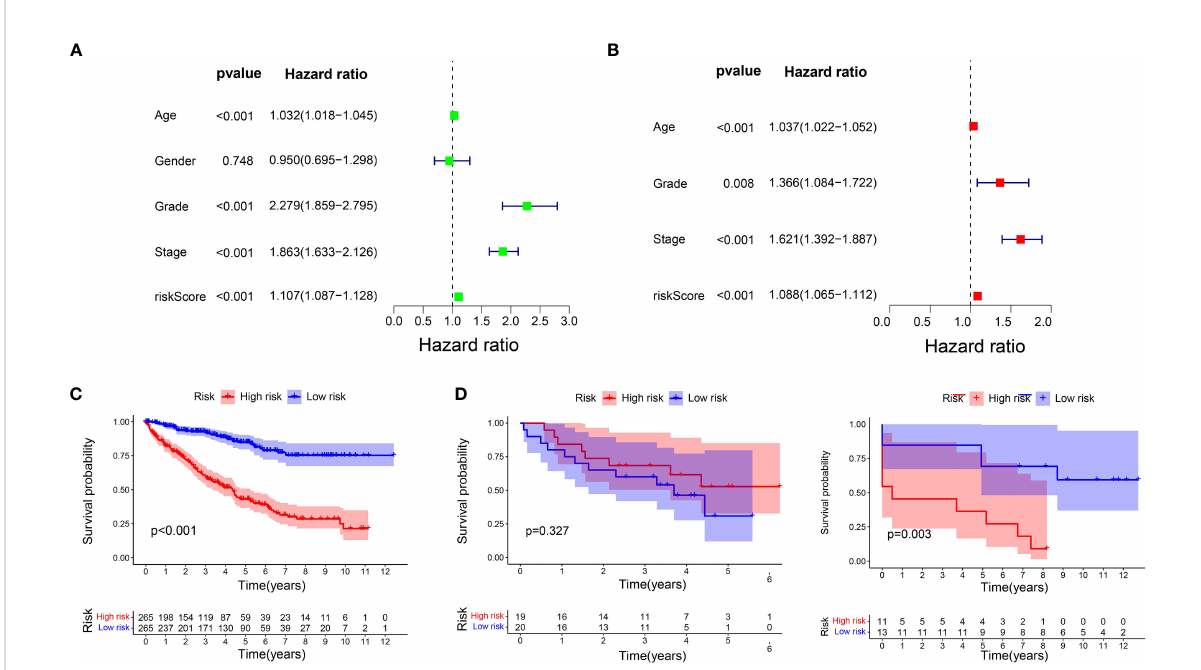
FIGURE 3 Prognostic analysis of the signature. (A) Univariate Cox regression analysis for the clinicopathological characteristics of 539 ccRCC samples in the TCGA cohort. (B) Multivariate Cox regression analysis for the clinicopathological characteristics of 539 ccRCC samples in the TCGA cohort. (C) K-M analysis of the signature in TCGA cohort. (D) K-M analysis of the signature in GSE29609 and